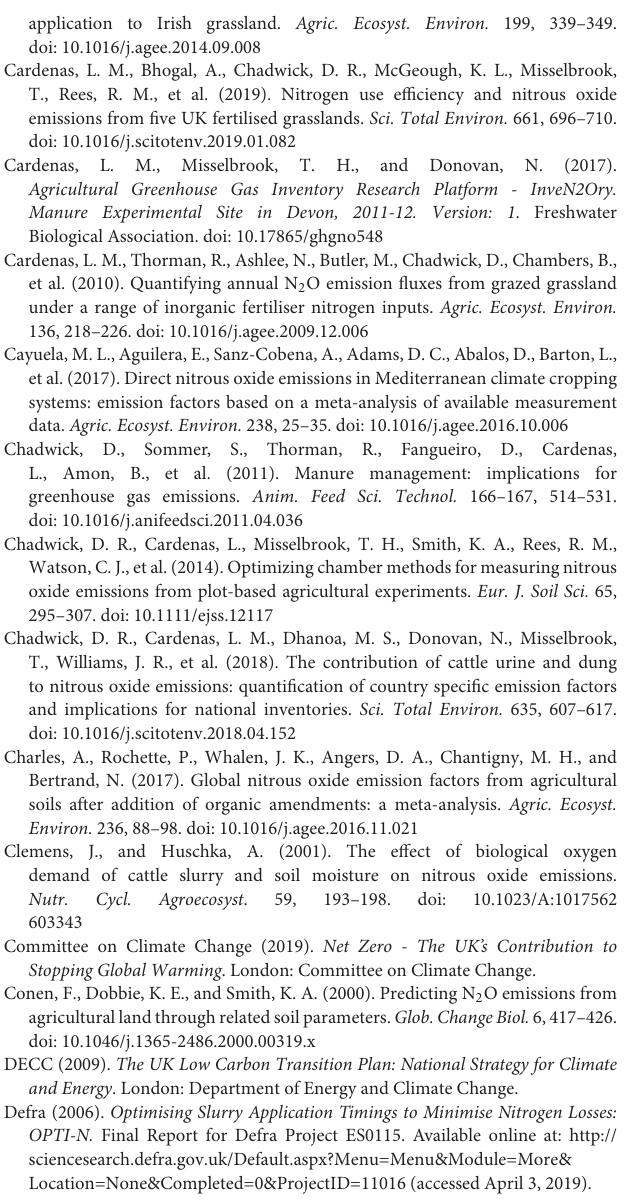
Supplementary Figure 1 | Example plot layout. NB Plots are at an angle to facilitate the placement of ammonia windtunnels so that clean air can flow into the